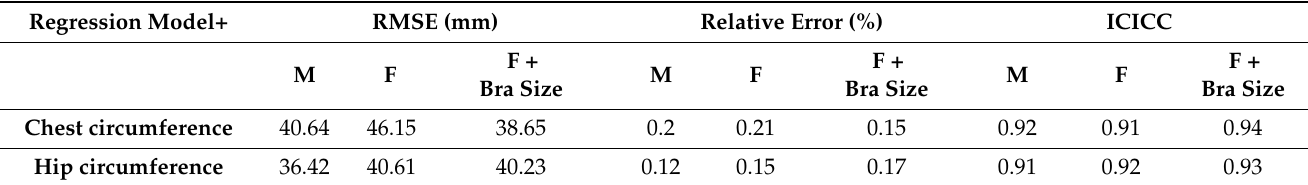
Table 8. Overview of results on the regression model prediction based on the base parameters with the bra size